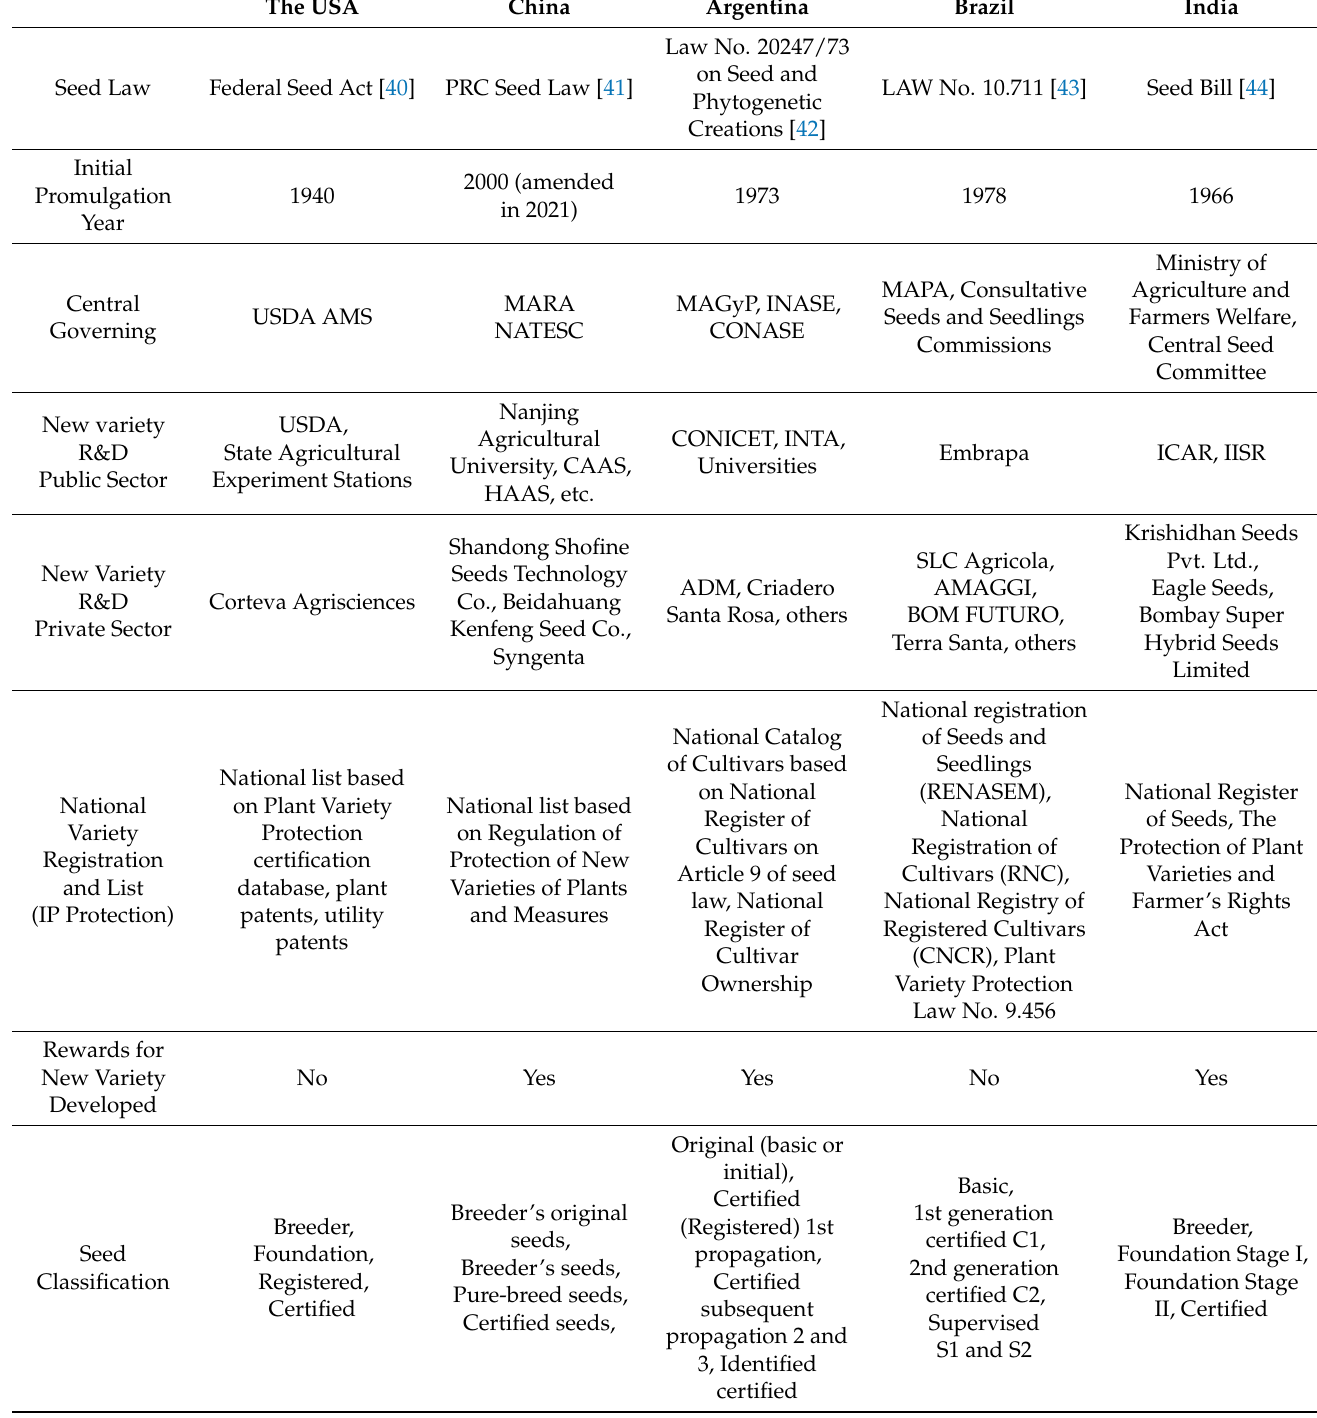
Table 1. Overview of soybean seed laws, rules, regulations and systems by